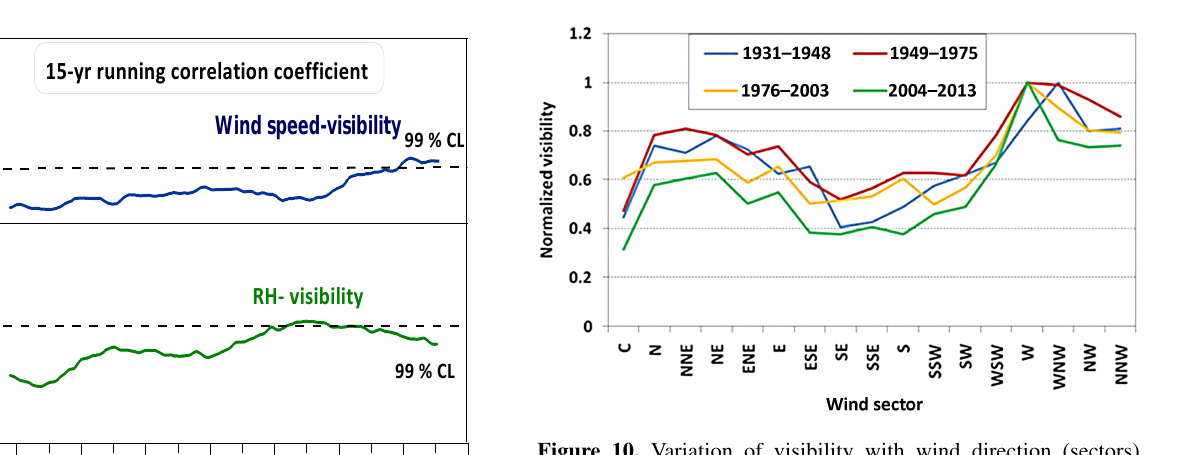
Figure 10. Variation of visibility with wind direction (sectors) over the subperiods 1931–1948, 1949–1975, 1976–2003 and 2004– 2013. Visibility is normalized by its maximum value at a certain sector for each subperiod. Sector “C” corresponds to calms (wind speed < 0.3ms − 1 ) . Frequency of each sector approximates closely its climatic value (Fig. 3) in all